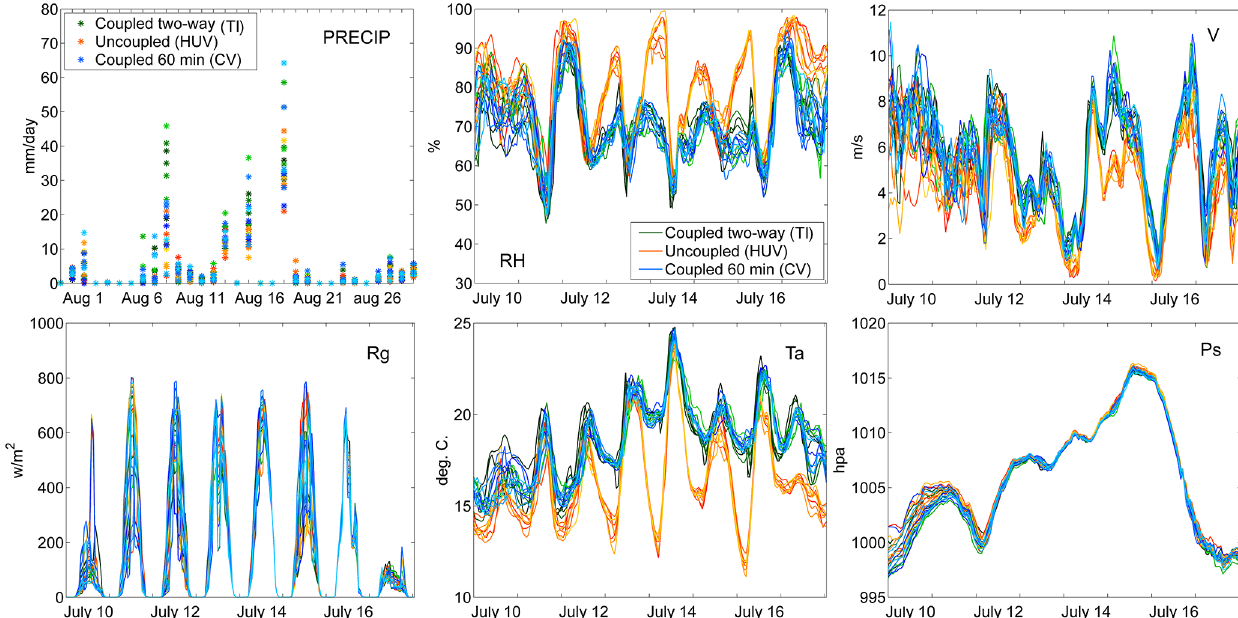
Figure 7. The six HIRHAM output variables assessed in the present study in the 10–17 July period (precipitation is 1–31 August to match the period in Fig. 9 with a higher dynamic in discharge) for all 24 TI, HUV and CV runs and for Dom1 (nine cell mean). The legend colouring reflects the overall simulation group (TI, HUV or CV) whereas each simulation is in the colour shade as in Fig.